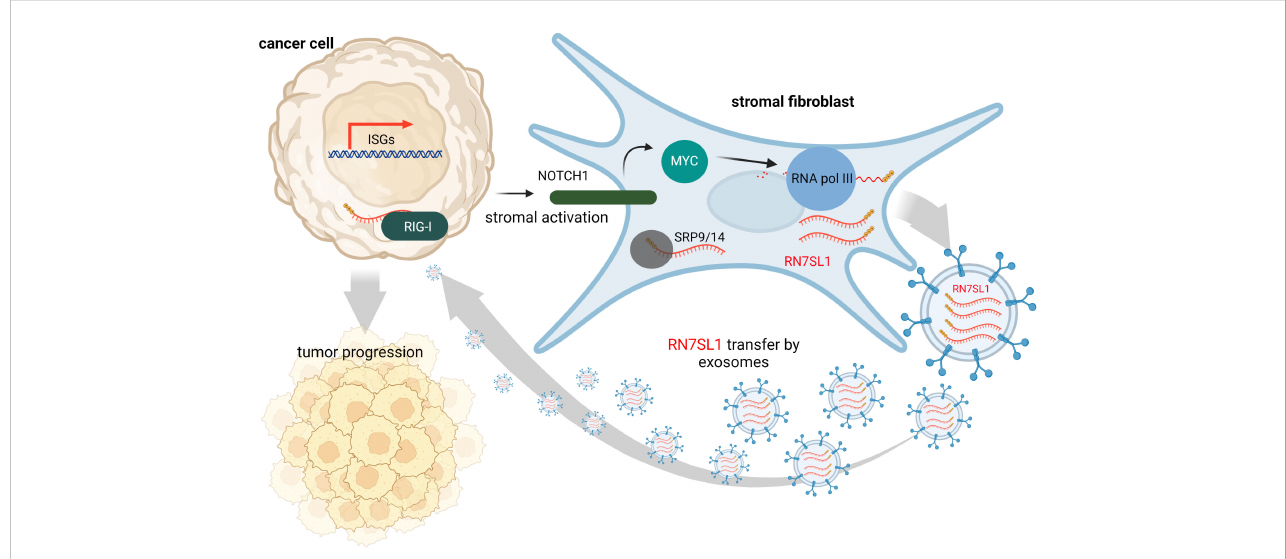
FIGURE 2 During contact with stromal fi broblasts, breast cancer cells activate NOTCH1/MYC signaling that leads to higher transcription of ncRNA RN7SL1 carrying 5 ’ -ppp. These transcripts then remain unshielded since levels of their protein-binding partner (SRP9/14) remain constant. Naked RN7SL1 is loaded to exosomes and, upon interaction with breast cancer cells, can activate RIG-I signaling leading to an in fl ammatory tumor microenvironment that can promote tumor progression and poor clinical